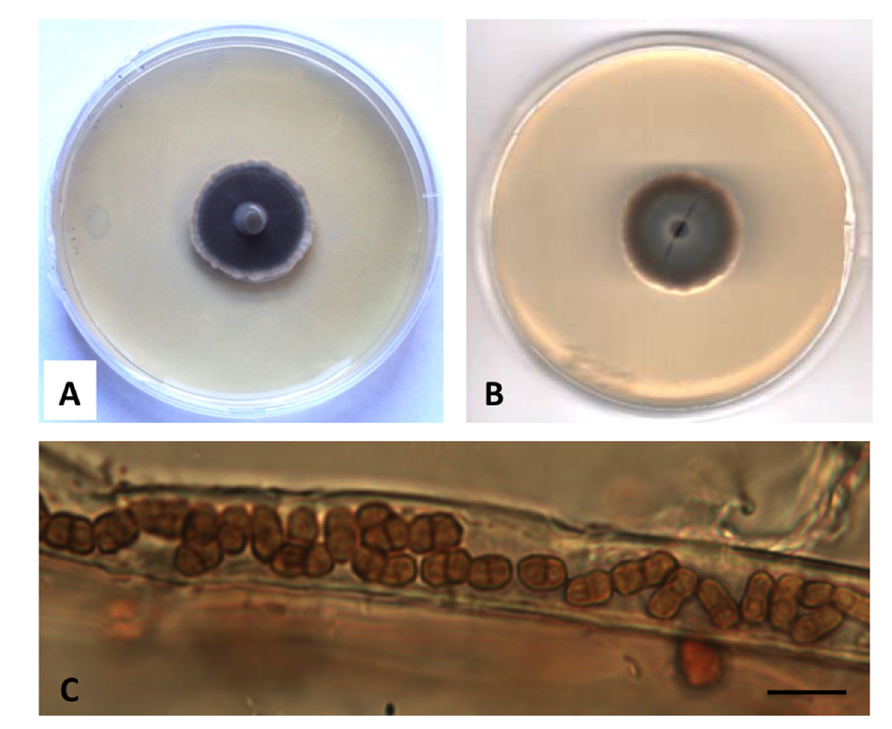
Figure 5. Neoroussoella lignicola sp. nov. 28-days-old colony at 21 °C on MEASW ( A ) and reverse ( B ); two-celled chlamydospores inside wood vessels ( C ). Scale bar: 10 µm. Roussoella margidorensis sp. nov. E. Bovio, V. Prigione, A. Poli and G.C. Varese MYCOBANK: MB